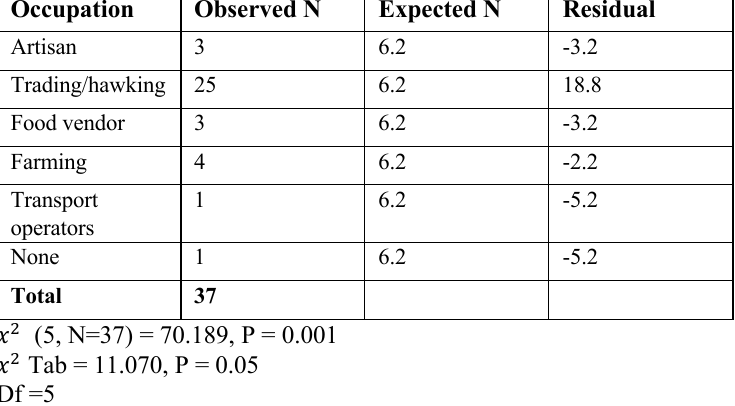
Table 2. Statistical Analysis of Occupation of Hawkers’ Employer